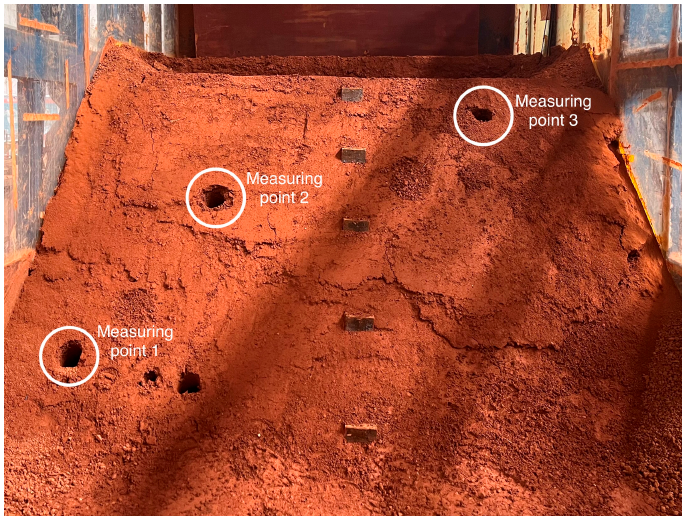
( b ) Figure 12. Earth pressure at representative measurement points in each group of tests. ( a ) Meas- urement point S6. ( b ) Measurement point S7. 4. Discussion The above study analyzed the effects of single variables of bamboo rhizomes and rainfall on the deformation and mechanical properties present during the sliding of slopes. However, the impact on the soil in the case of mutual coupling between the two still requires additional exploration. The coupling effect can be reflected in the superposi- tion of the values of a certain characteristic of the slope. Therefore , it is valid to compare the displacement and earth pressure in test G3 with that in test G1 to derive the coupling effect of bamboo rhizomes and rainfall. Then, ensuring that the bamboo rhizomes and